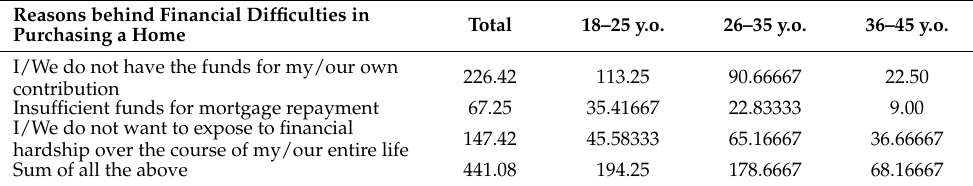
Table 5. Reasons behind financial difficulties in purchasing a